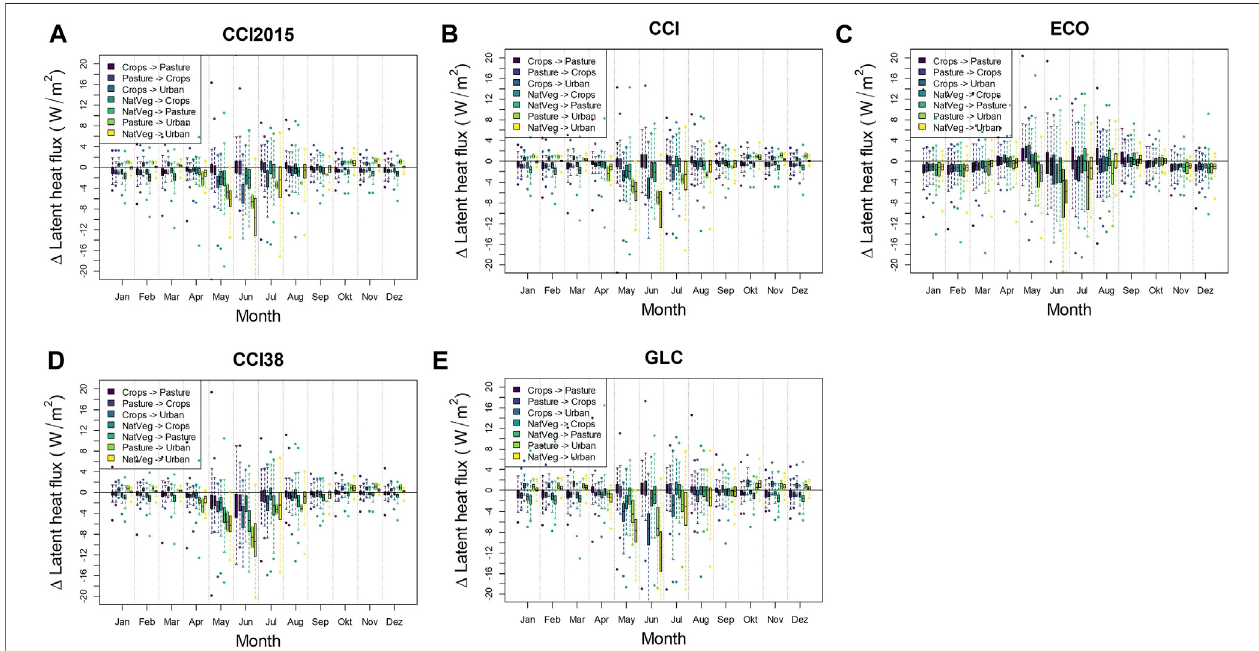
FIGURE 11 | Monthly differences in daily latent heat fl ux due to dominant land cover changes (more than 40%) between CCI2015 and GC (A) , CCI and GC (B) , ECOandGC (C) ,CCI38andGC (D) ,andGLCandGC (E) forthetimeperiodfrom2002to2011.Croplandgridcellschangeintopasturetype(purple),pasturegridcells change into crops (dark blue), crop grid cells change into urban type (blue), natural vegetation grid cells change into crop type (dark green), natural vegetation grid cells changeintopasturetype(green),pasturegridcellschangeintourbantype(lightgreen),andnaturalvegetationgridcellschangeintourbantype(yellow).Differences are calculated for grid cells, where the listed land cover type change occurs. Please see Table 1 for abbreviations of simulation experiments.